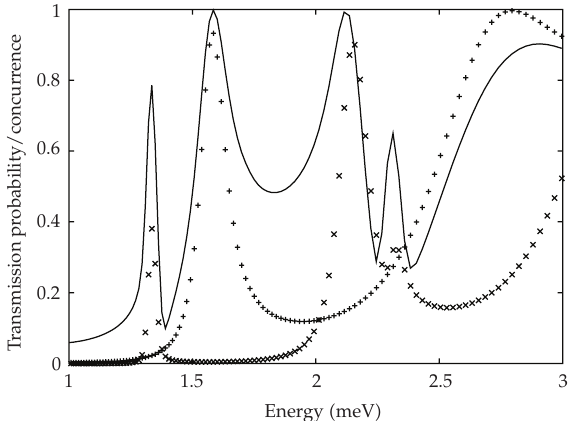
√ 2 state (cid:9) solid line (cid:10) and